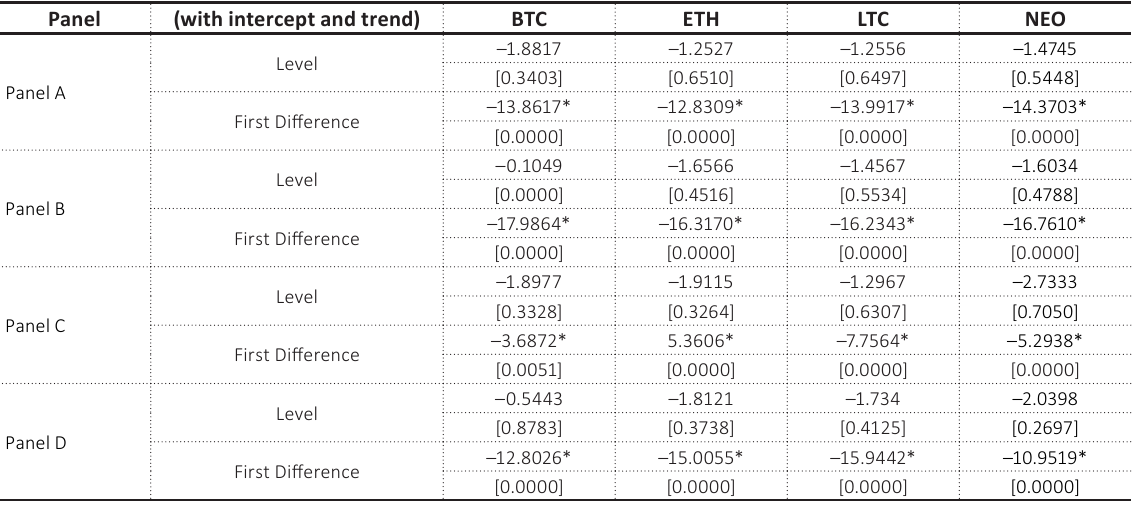
Table 3. Augmented Dickey-Fuller (ADF) tests on cryptocurrencies